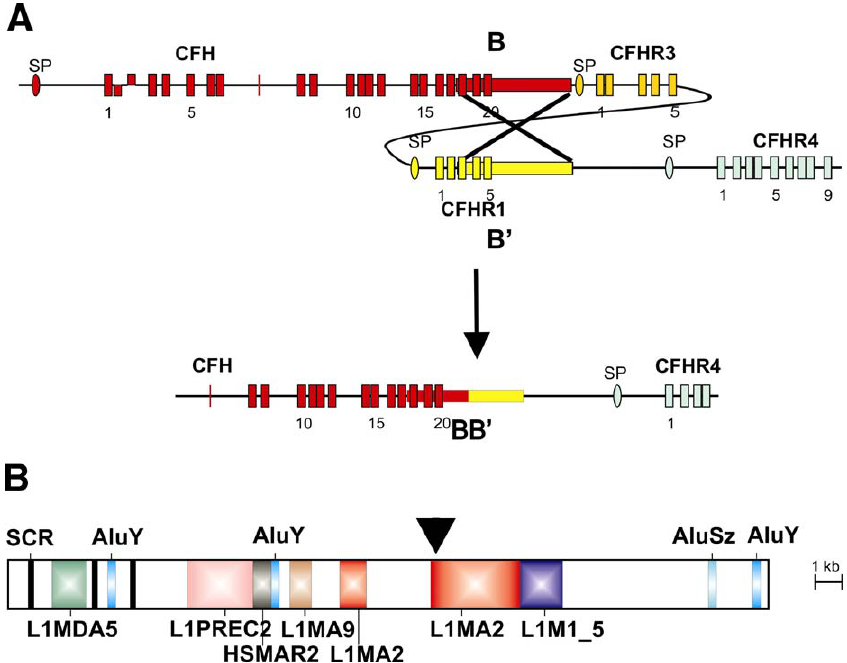
Figure 3. Chromosomal Rearrangement of Segments B and B 9 (A) Homologous recombination between segments B and B 9 in the RCA gene cluster results in deletion of the genes coding for CFHR1 and CFHR3 and fusion of segments B and B 9 as described in the text. (B) The B and B 9 segments in the factor H gene cluster are characterized by high sequence identity (98%) and include several truncated long interspersed nuclear elements (retrotransposons). The breakpoint identified in all three patients is indicated by the arrow.